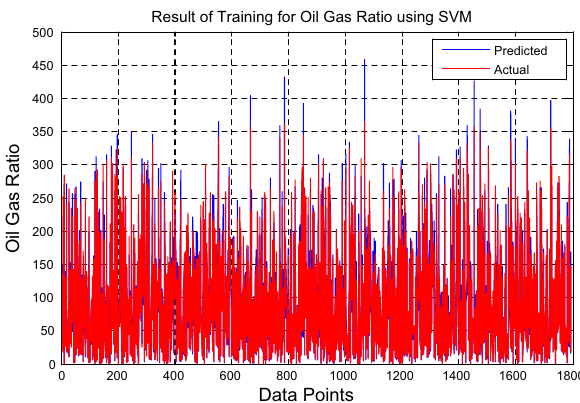
Fig. 14 Cross-plot of R v using SVM for